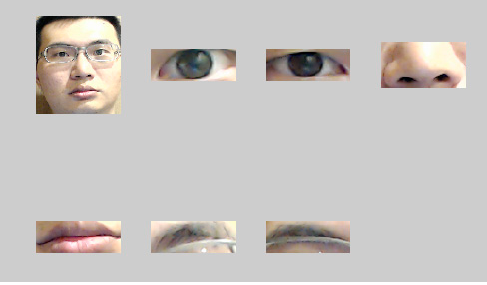
Figure 7. The interest face features of eyes, nose, mouths, and eyebrows.